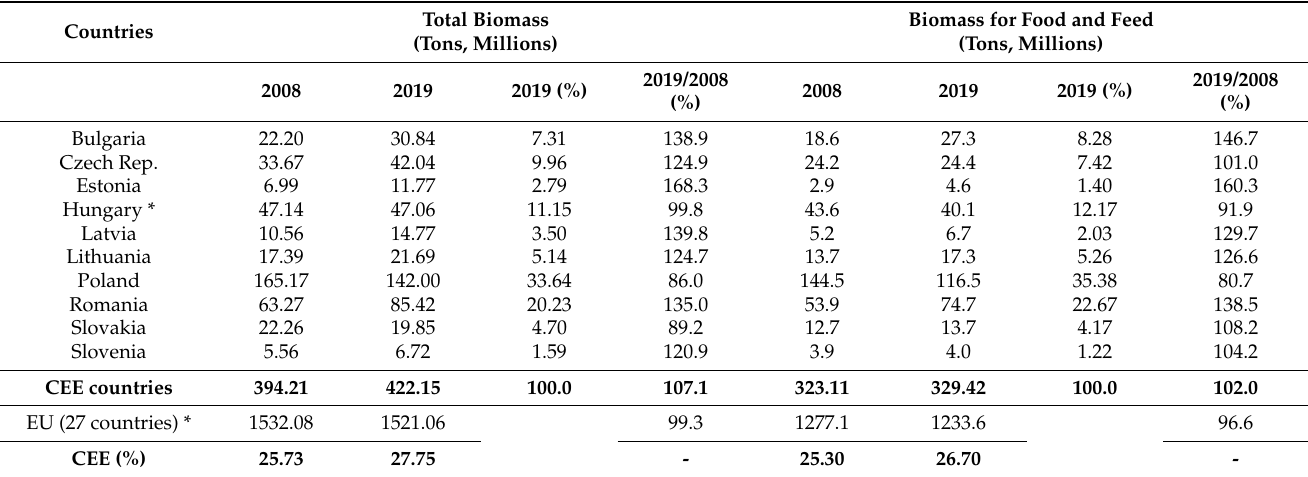
Table 6. Domestic extraction of biomass used and domestic extraction of biomass for food and feed